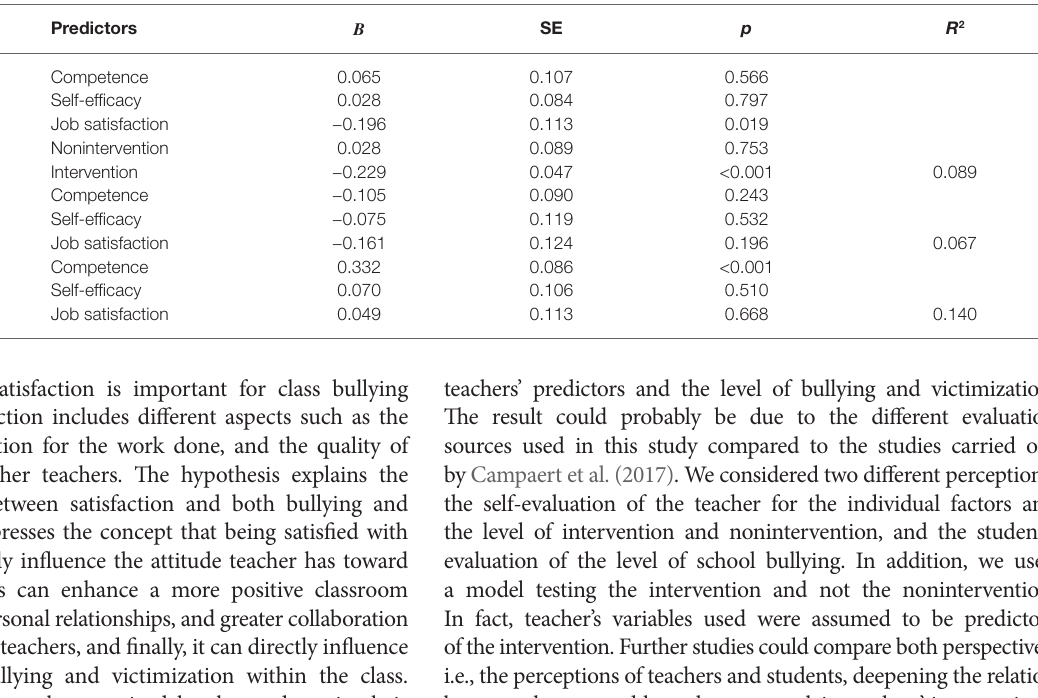
TABLE 2 | Estimated regression coefficients in the model of bullying.